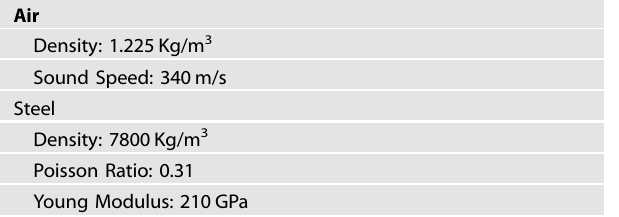
Table 1. Material properties.